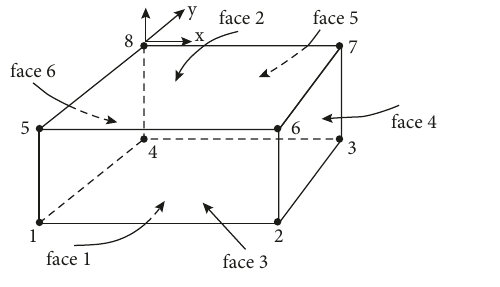
Figure 5: Eight-node brick element.